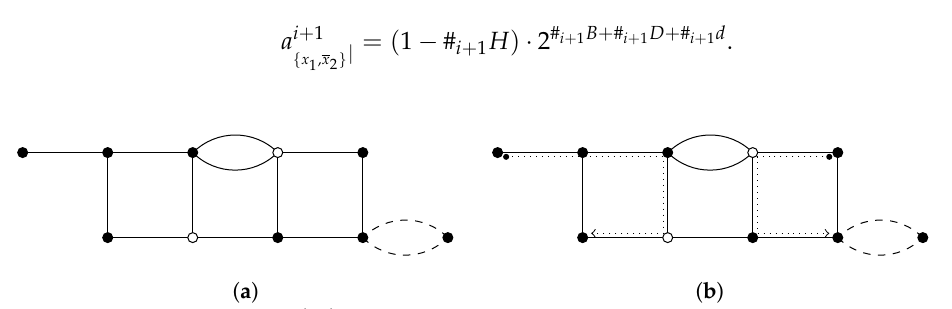
Figure 13. ( a ) Drawing of T i ⊗ of tile T i and left wall vertices of tile T i + 1 . ( b ) Dotted arrows show the only possible combination for a i , i + 1